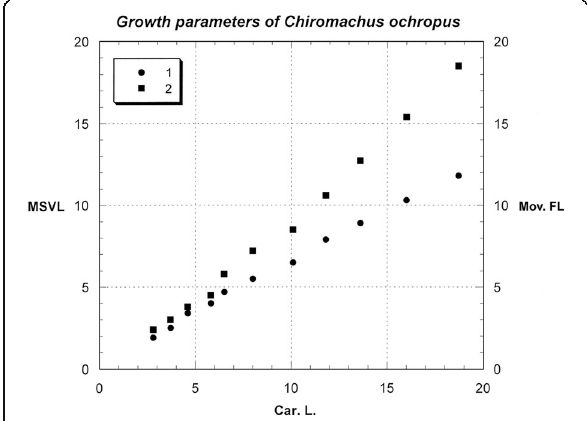
Fig. 18 Graph showing the growth parameters in the scorpion Chiromachus ochropus. Values are calculated from carapace length